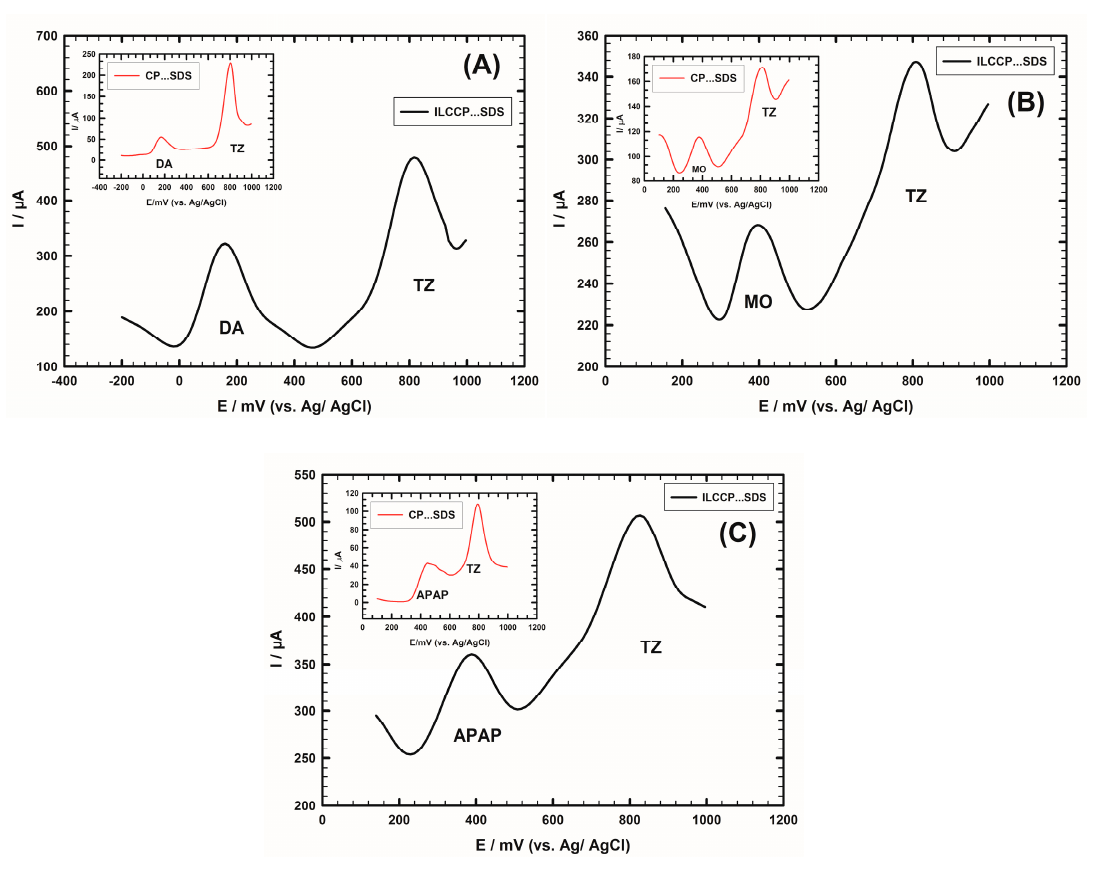
Figure 8. ( A ) DPV of 1 mmol · L − 1 TZ in the presence of 1 mmol · L − 1 DA at ILCCPE. . . SDS, the inset, the DPV of 1 mmol · L − 1 TZ in presence of 1 mmol · L − 1 DA at CPE. . . SDS; ( B ) DPV of 1 mmol · L − 1 TZ